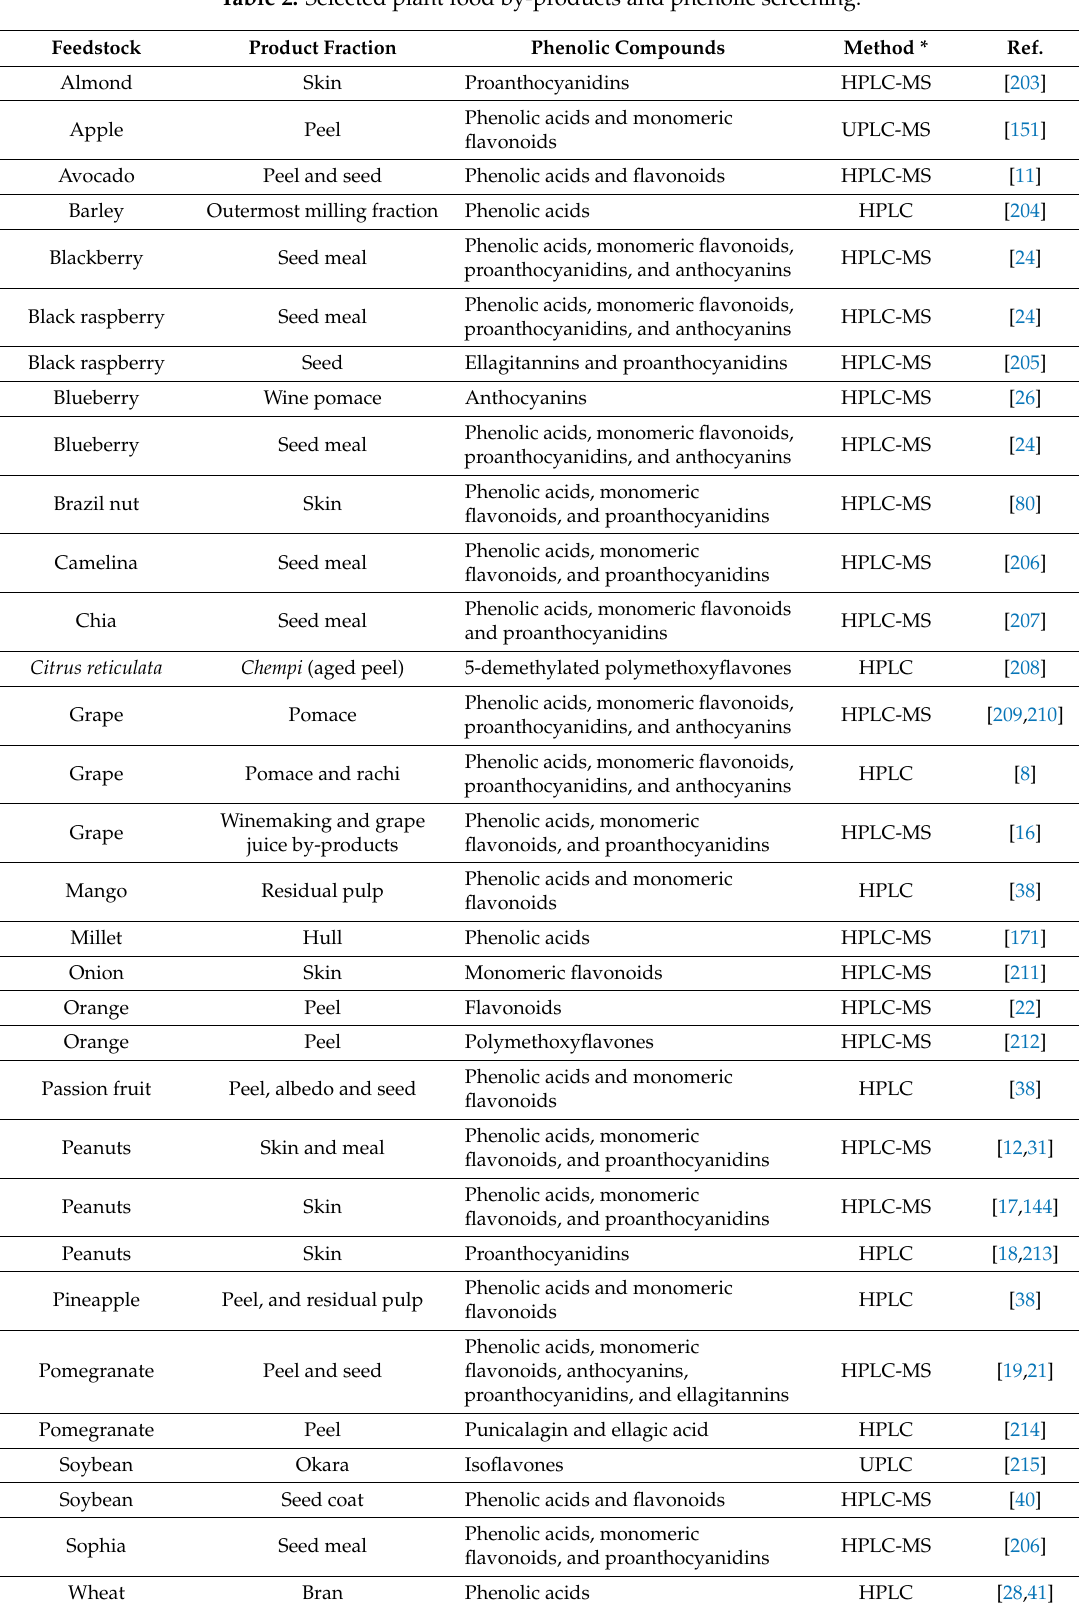
Table 2. Selected plant food by-products and phenolic